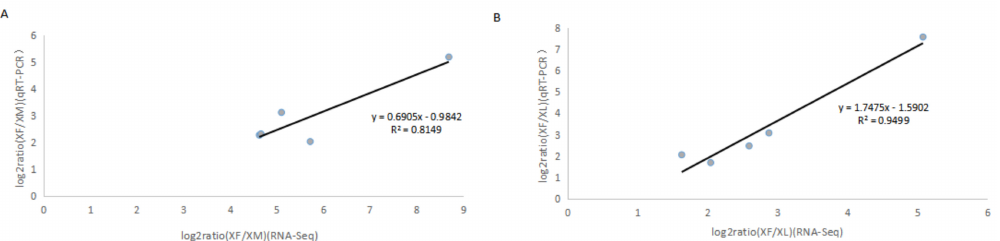
Figure 5. Expression levels of DEGs in Xenocatantops brachycerus. ( A ) Transcriptional variation of five genes between XL and XF, R 2 = 0.8149 indicates a very significant correlation between qRT-PCR and RNA-Seq data; ( B ) transcriptional variation of five genes between XM and XF. R 2 = 0.9499 indicates a very significant correlation between qRT-PCR and RNA-Seq